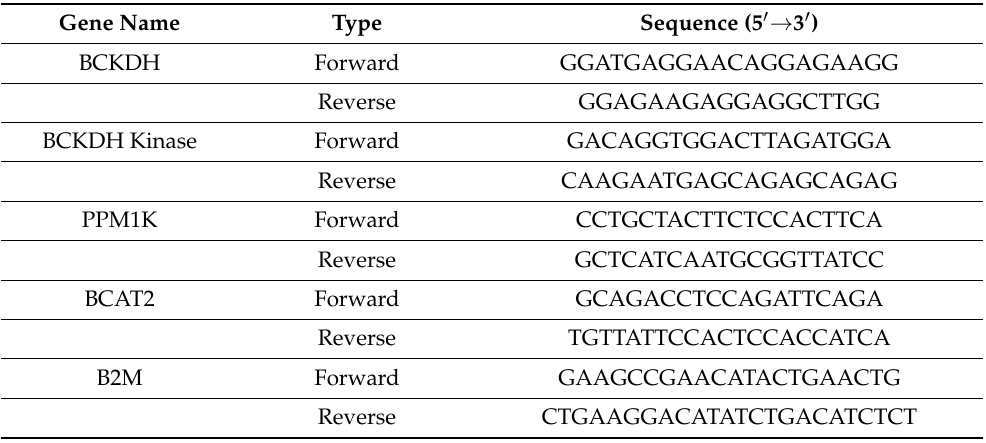
Table 1. Primer sequences